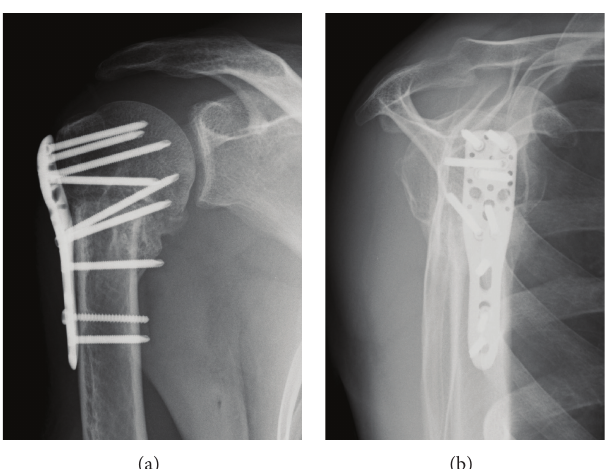
Figure 5: Both varus and retroversion deformities are successfully corrected after valgus closing-wedge osteotomy ((a) anteroposterior view, (b) scapula-Y view).